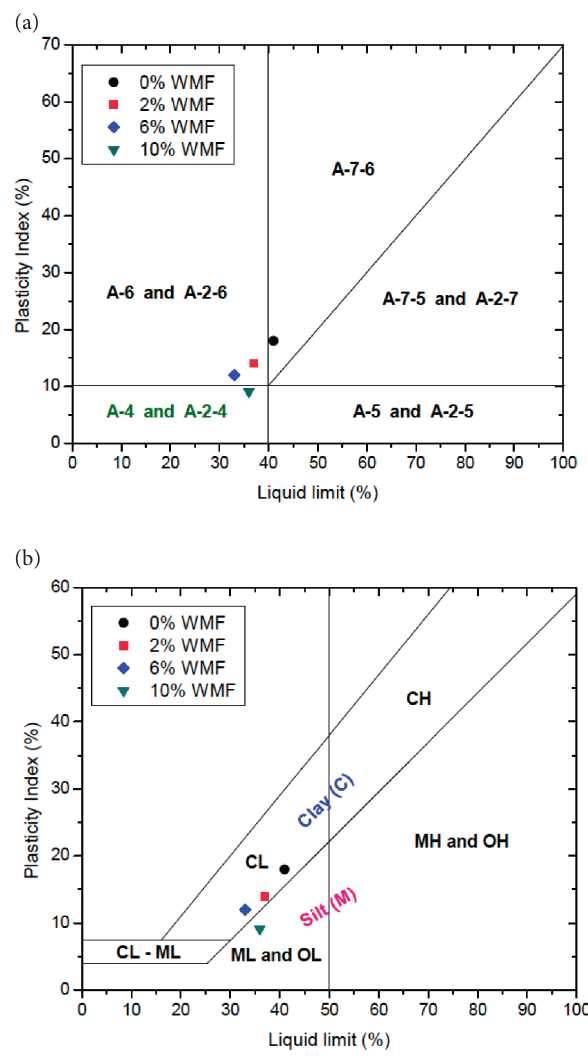
Fig. 7. Plasticity charts (a) AASHTO (b) USC showing the plots for the mean values for the natural and treated soil